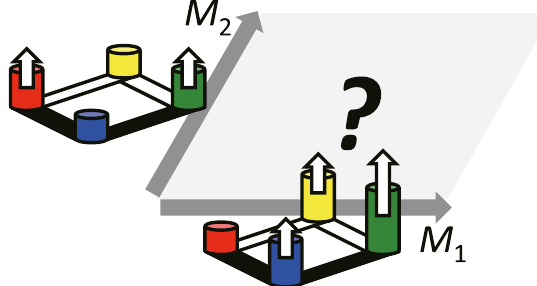
Figure 1 . The schematic picture of the analysis studying the (2 , 2)